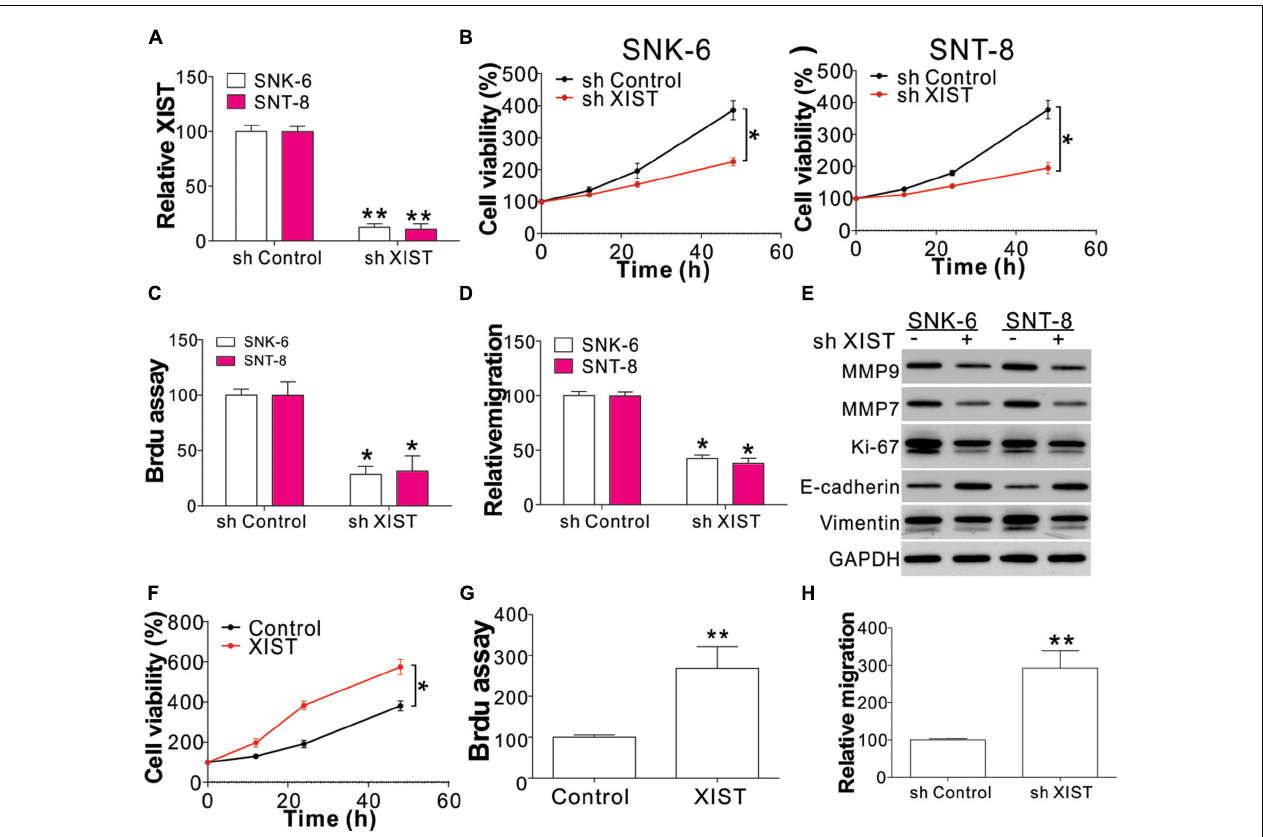
FIGURE 2 | XIST mediates ENKL cell proliferation and migration. (A) The mRNA level of XIST in ENKL cells with a stably transfected control or XIST shRNA. (B) The viability of ENKL cells with a stably transfected control or XIST shRNA at different time points. (C) The BrdU assay of ENKL cells with a stably transfected control or XIST shRNA. (D) The transwell assay of ENKL cells with a stably transfected control or XIST shRNA. (E) The expression of indicated proteins in ENKL cells with stably transfected control or XIST shRNA. (F) The cell viability of NK-92 cells with a stably transfected control or XIST expression vector at different time points. (G) BrdU assay analysis of NK-92 cells with a stably transfected control or XIST expression vector. (H) Transwell assay analysis of NK-92 cells with a stably transfected control or XIST expression vector. Each experiment was repeated for 3 times. * p < 0.05; ** p <